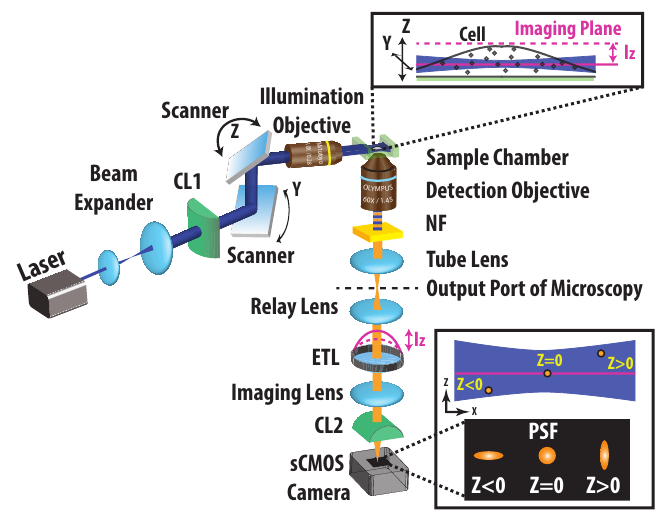
Figure 1. Schematic setup of light sheet microscope used to record 3D trajectories of probing nanoparticles in a living cell. The excitation beam was shaped to form a 3.0 µ m-thick light sheet, giving a Rayleigh range of 41 µ m. A two-dimensional (2D) scanner was inserted to move the light sheet by 34 µ m along the y - and z -directions at the sample position. The imaging arm was perpendicular to the excitation direction, and an imaging plane in the sample was relayed and imaged to an scientific complementary metal-oxide semiconductor (sCMOS) camera. The position of the imaging plane was adjusted using an electrically tunable lens (ETL) to yield a set of depth-resolved images. An astigmatism was introduced using a CL2 to encode the information on fluorophore depth into an elliptically